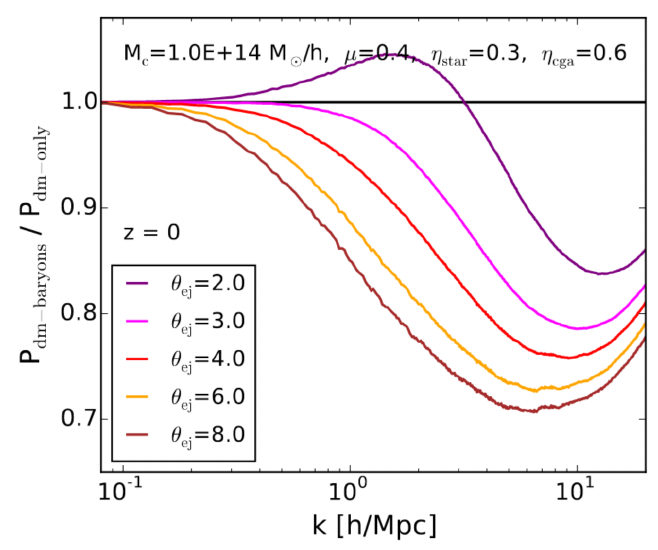
Figure 18. Modification of the local matter power spectrum with respect to pure N-body simulations in the presence of AGN feedback at the scale of galaxy groups in the semi-analytic model of Schneider et al. [329]. The various curves show how the power spectrum depends on the parameter θ ej governing gas ejection from the central regions of groups under the influence of AGN feedback. A strong ejection of gas from the core of halos implies substantial modifications to the matter power spectrum on scales of ∼ 1 Mpc. The figure reproduced from Schneider et al.